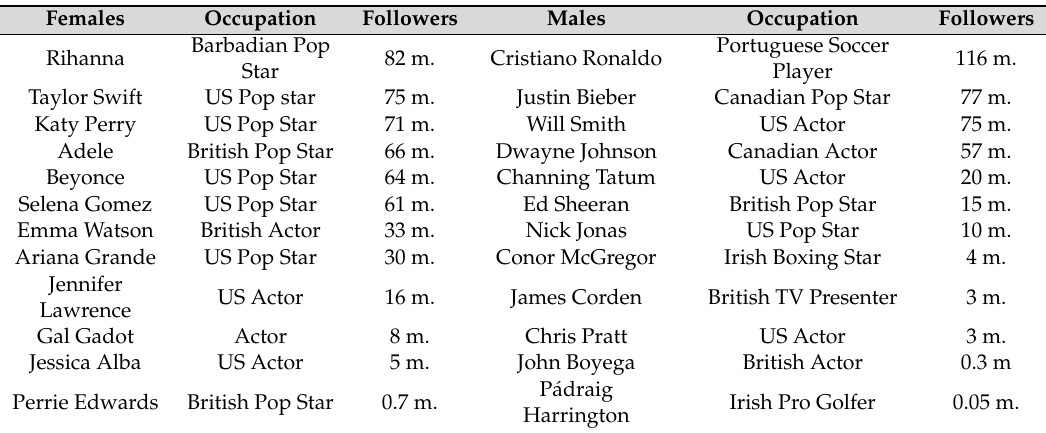
Table 1. Celebrities that appeared as sources of advertising posts and number of followers on Facebook at the time of the study.